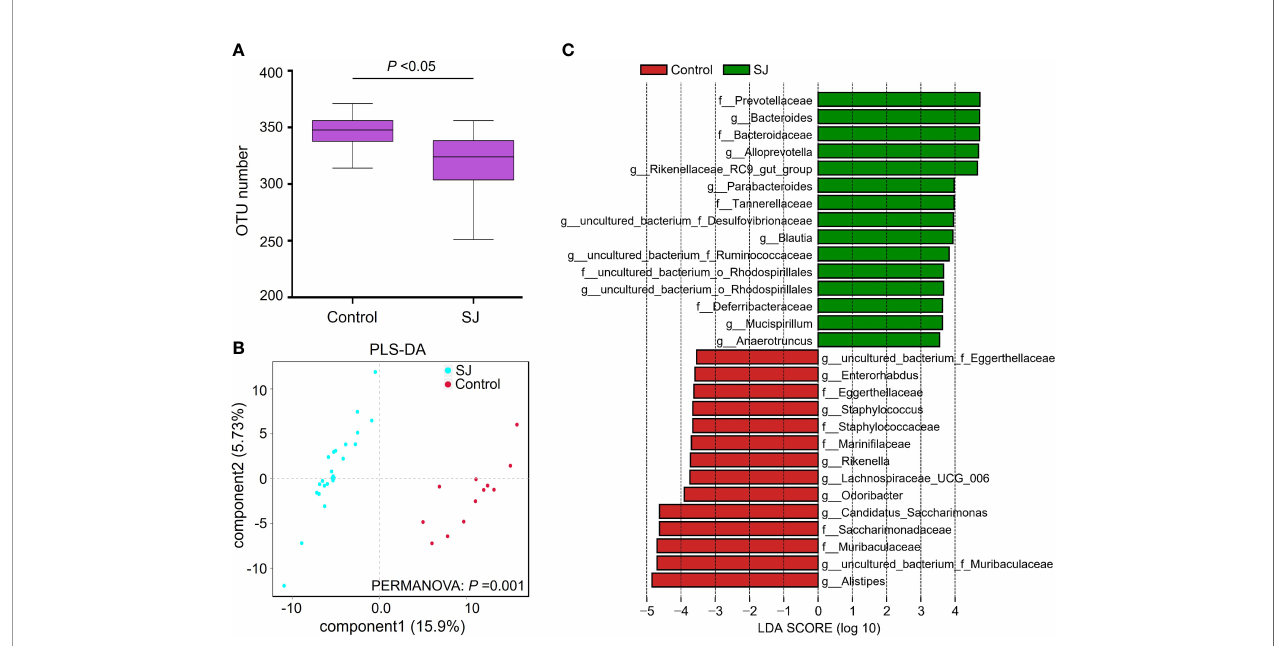
FIGURE 1 | Comparisons of gut microbiota between S. japonicum- infected (n = 24) and uninfected (n = 12) mice. (A) OTUs analysis. (B) PLS-DA analysis. (C) Differential gut bacterial taxa were analyzed by LEfSe analysis with LDA score >3.5 between groups. Control: without S. japonicum infection mice. SJ: S. japonicum- infected mice. * P < 0.05 indicates signi fi cant